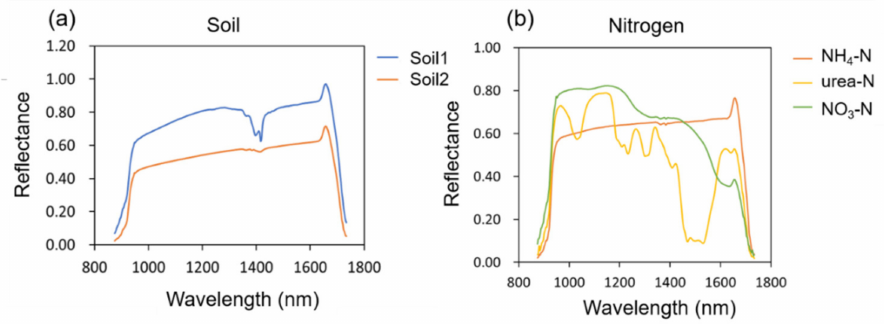
Figure 1. Spectra of soils and nitrogen fertilizer standards: ( a ) Spectra of soil1 and soil2; ( b ) Spectra of nitrogen fertilizer